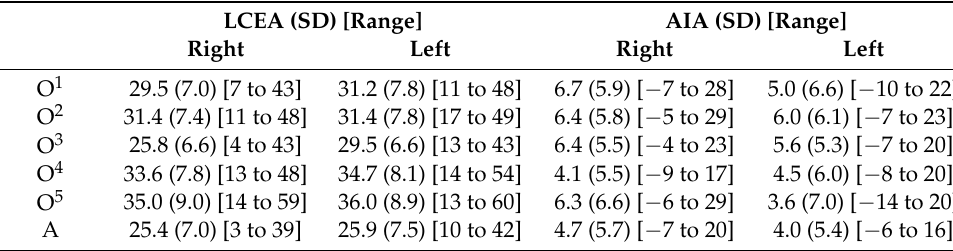
Table 2. Mean measurements of LCEA and AIA including SD and range for all readers and Algorithm (A) (n =